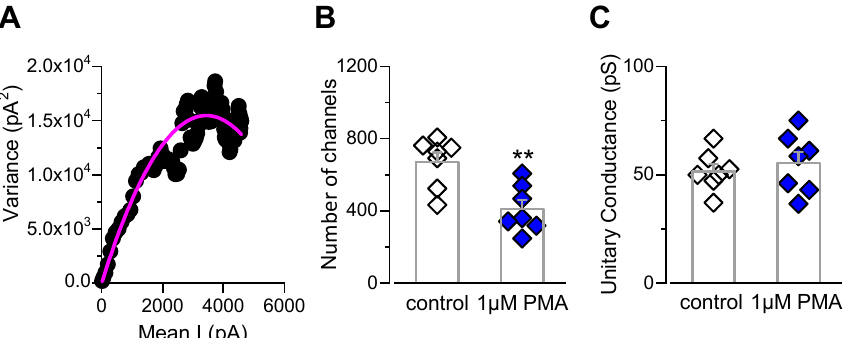
Figure 3. PKC activation by PMA induces a drop in the number of active TRPM8 channels at the plasma membrane. ( A ) Dot plot of variance versus mean current obtained from whole-cell currents of a HEK-293 cell stably expressing mTRPM8-myc channels, using 150 ms depolarizing voltage steps from 0 to +180 mV, at 19 °C. Solid line corresponds to fit of data to a parabola (Equation (2)). ( B , C ) Bar graph representing mean and S.E. and data points of the number of active channels ( B ) and unitary conductance ( C ) for cells preincubated for 10 min with 1 µM PMA (blue symbols) or control solution (white symbols). Statistical significance was assessed with a two-tailed unpaired Student’s t test; ** p < 0.01, n = 7 cells for each condition.